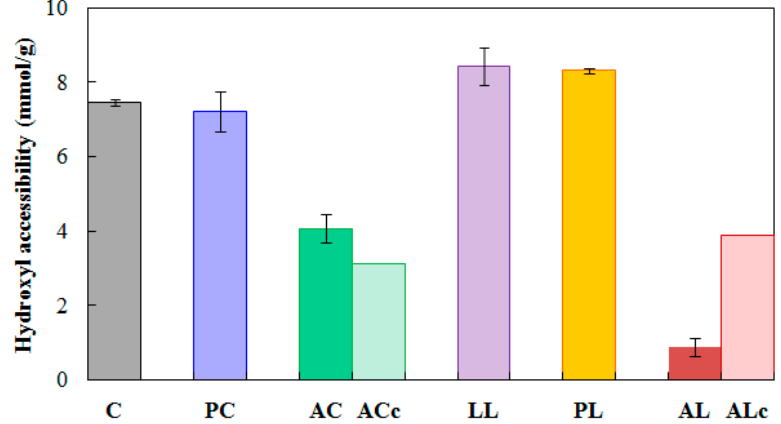
Figure 7. Hydroxyl accessibility of control wood (C), pyridine-treated wood (PC), acetylated wood (AC), wood with low lignin (LL), pyridine-treated wood with low lignin (PL), and acetylated wood with low lignin (AL). ACc: the calculated hydroxyl accessibility of AC. ALc: the calculated hydroxyl accessibility of AL.